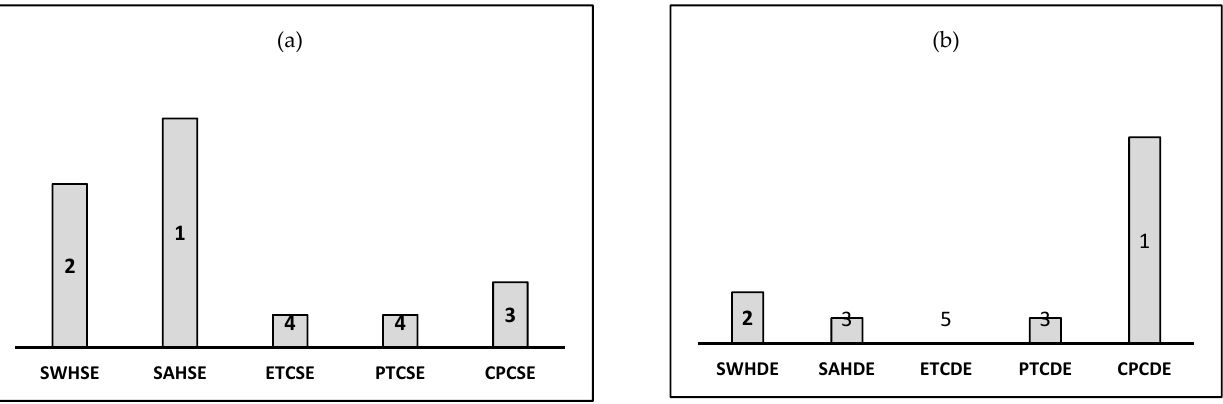
Figure 8. ( a ) Overall Ranking for Dwa weather scenario SE, ( b ) Overall Ranking for Dwa weather scenario DE.